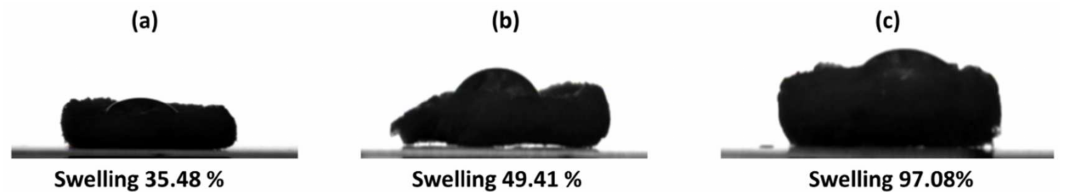
Figure 4. Swelling of chitosan scaffold before and after Non-thermal, biocompatible plasma (NBP) treatment. ( a ) Without treatment, the chitosan showed 35.48% swelling, while after NBP treatment, the swelling of the chitosan scaffold increased significantly: ( b ) 49.41% with 3 min treatment and ( c ) 97.08% with 5 min treatment.